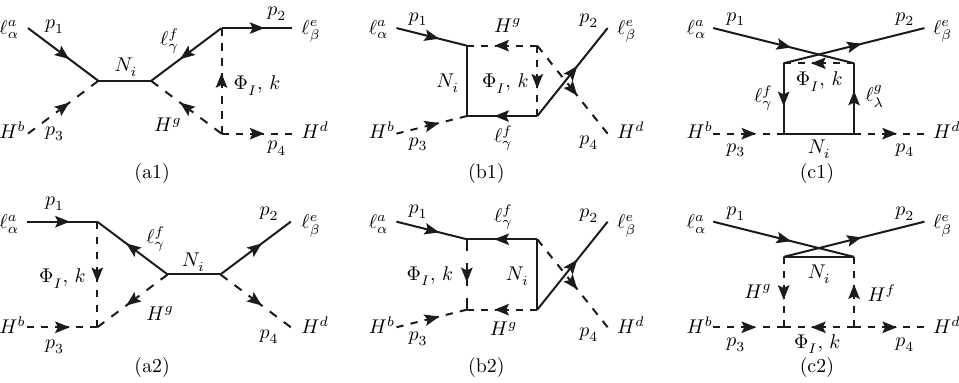
Figure 3 . The 1LPI diagrams with external lines generated by the (cid:0) ‘‘H † H (cid:1) field configuration in the type-(I+II) seesaw